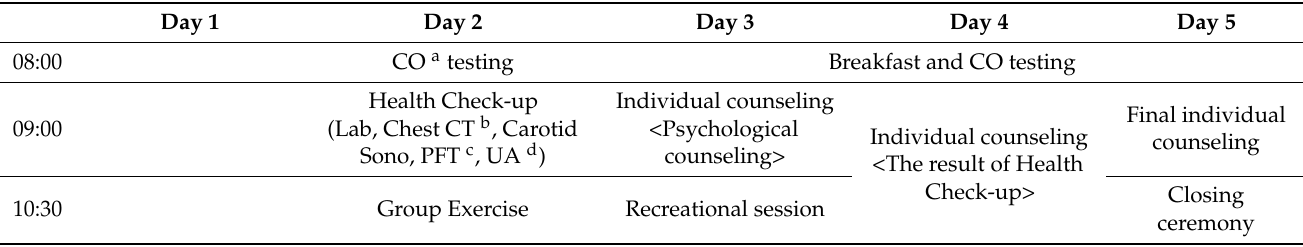
Table 1. Schedules of residential smoking cessation